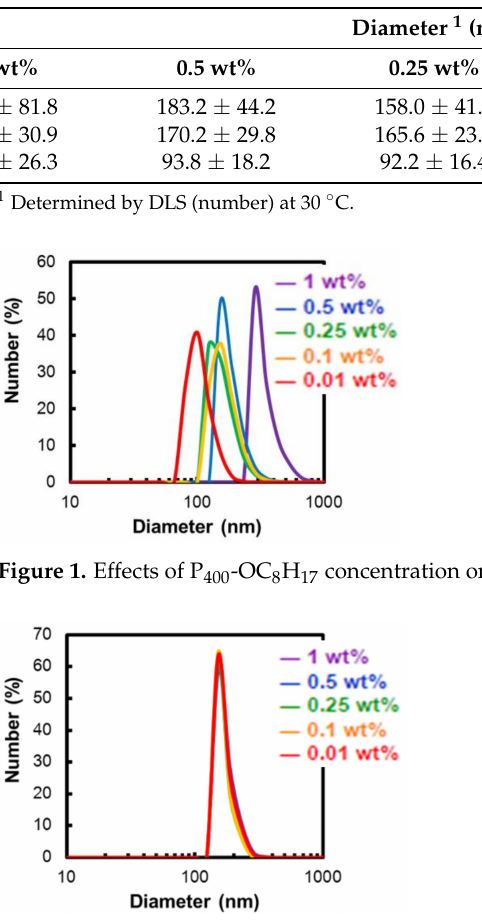
Figure 2. Effects of P 400 -OC 10 H 21 concentration on micelle size distribution.